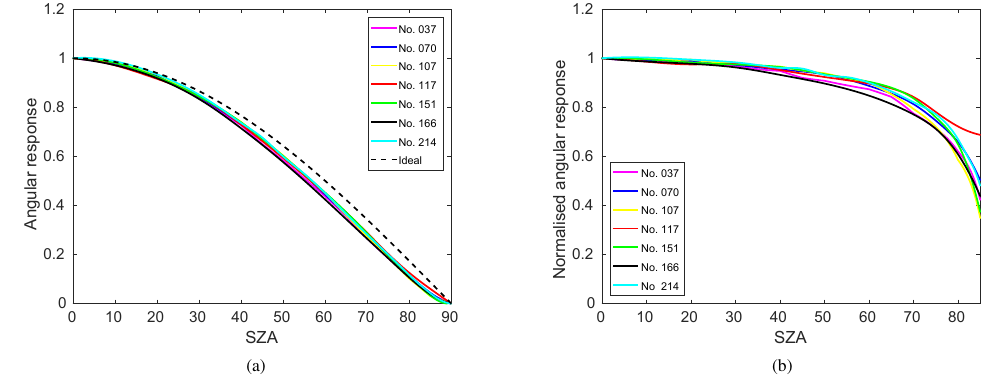
Figure 3. (a) Angular responses and (b) angular responses normalised to the ideal cosine response (cosine error) of Brewers no. 037, no. 070, no. 107, no. 117, no. 151, no. 166 and no. 214 at 310nm.